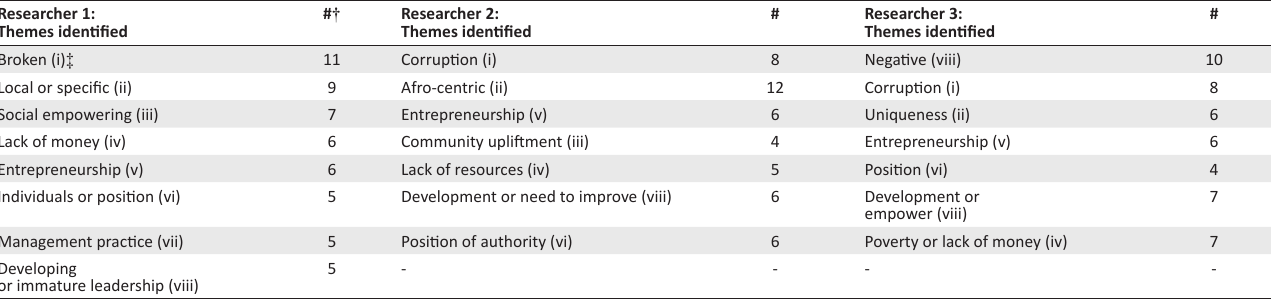
TABLE 2: Themes as identified by researchers in Cohort 1 ( N =